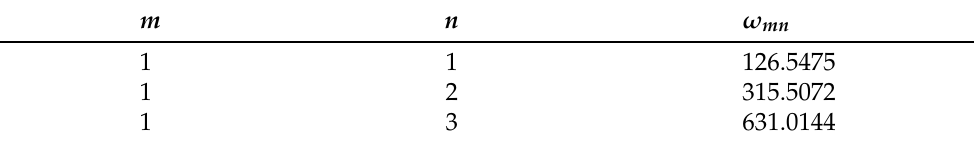
Table 1. Vibration modes.